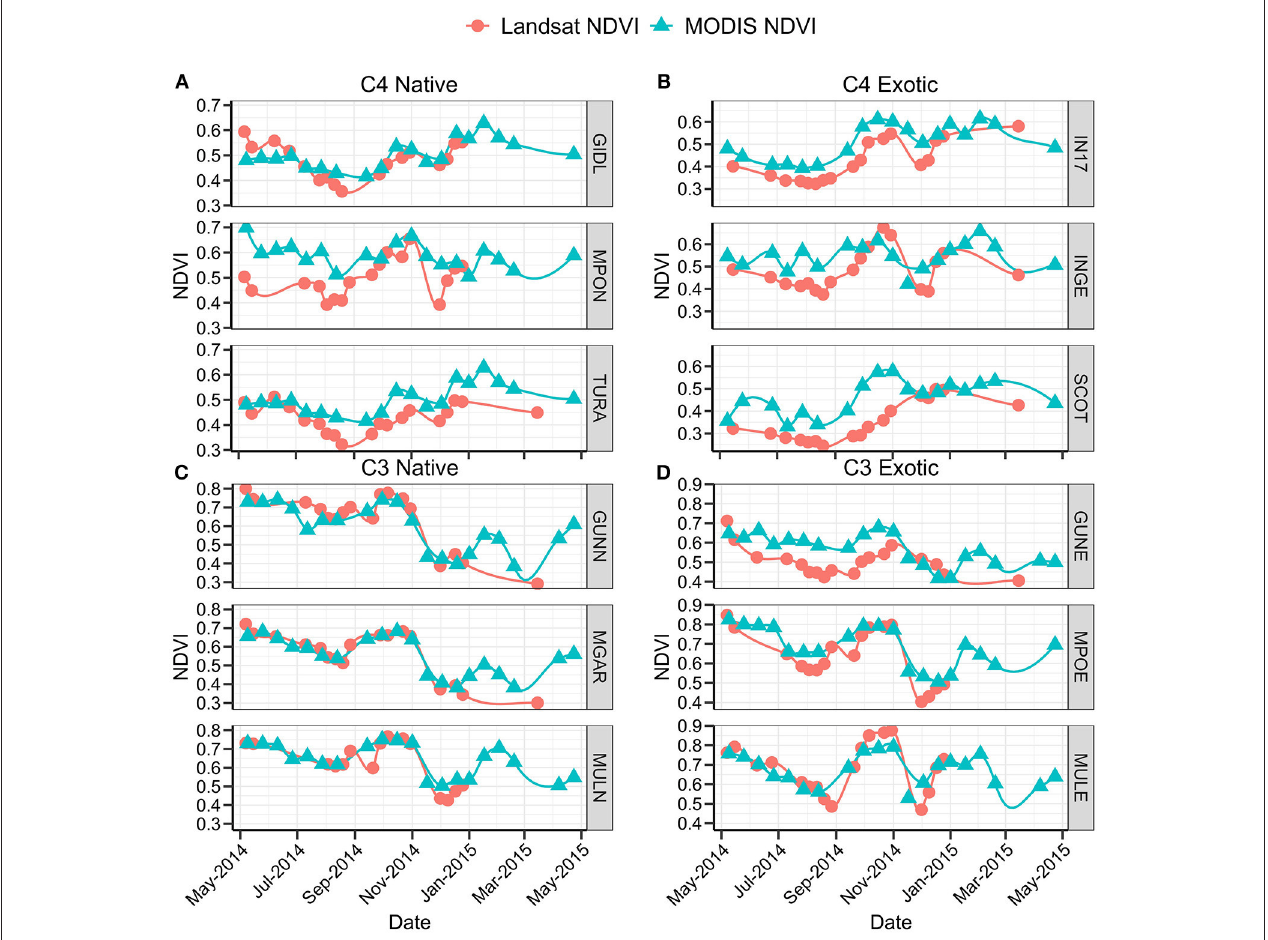
FIGURE 6 | Terra MODIS ( N ) and Landsat OLI/ETM + (•) NDVI data for 1 May 2014–30 April 2015 at (A) C 4 Native sites, (B) C 4 Exotic sites, (C) C 3 Native sites, (D) C 3 Exotic